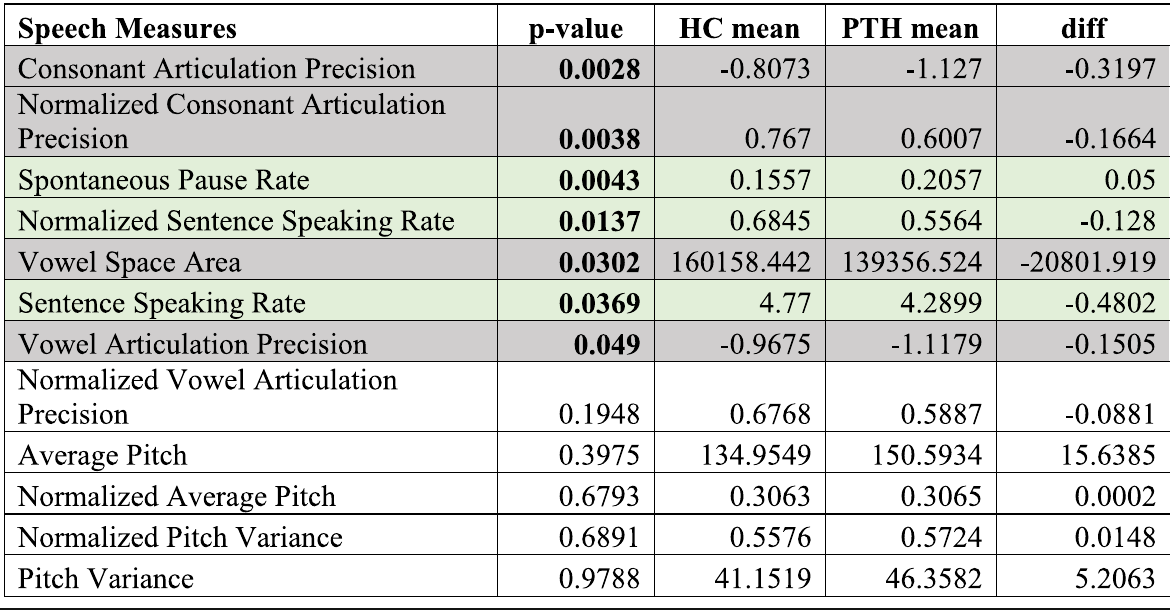
Table 4 Differences in speech patterns between HC and PTH patients during headache. Results of linear mixed model with individuals as random effects, controlled for age and